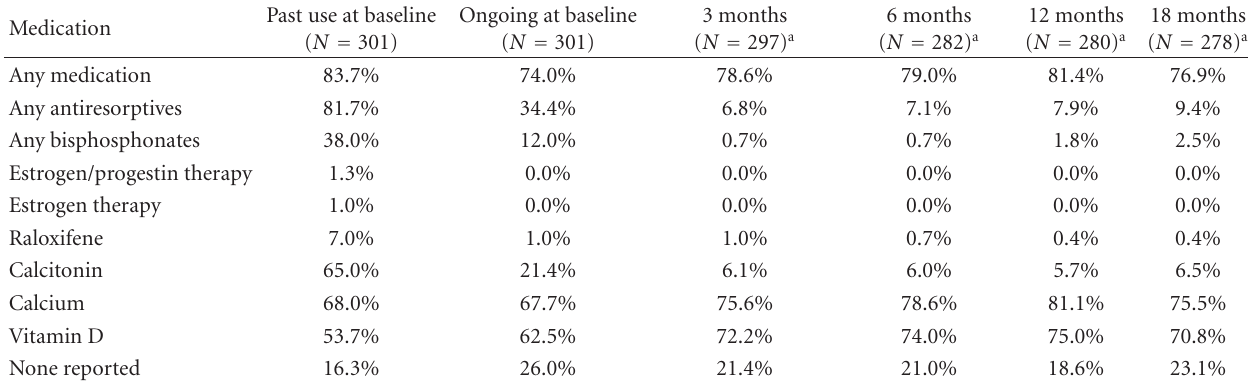
Table 1: Osteoporosis medications (other than teriparatide) prior and during the course of the study.